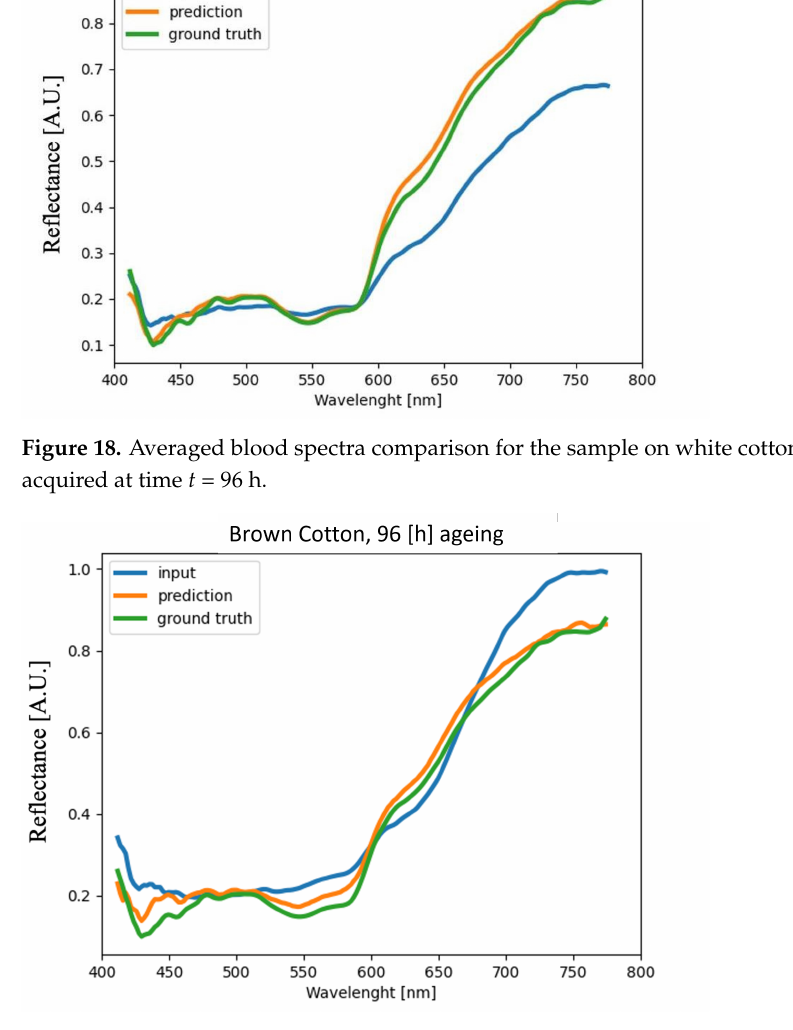
Figure 19. Averaged blood spectra comparison for the sample on brown cotton fabric substrate and acquired at time t = 96 h. Table 2. MAPE in blood stain age determination for blood deposited in two new materials: brown and white cotton